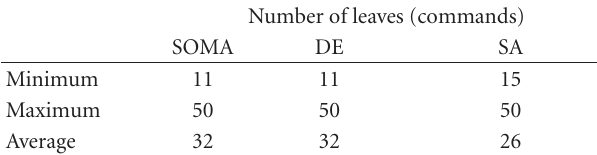
Table 5: Number of commands.